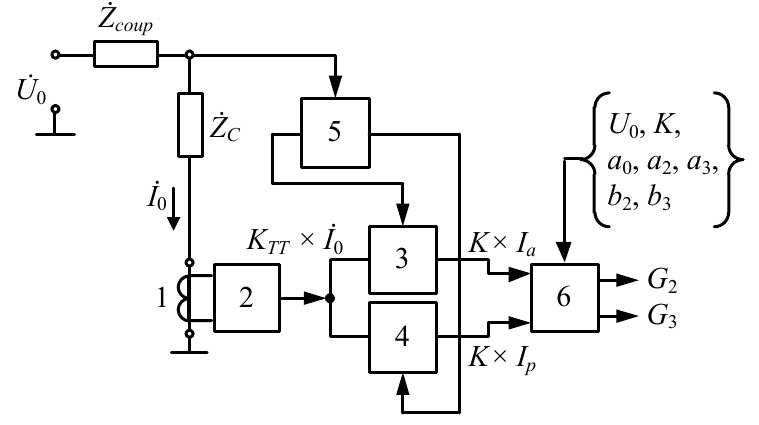
Figure 7. The AHFML’s structure flowchart.